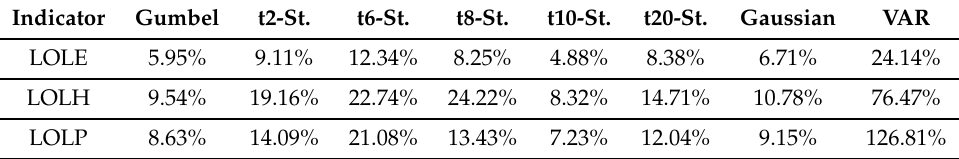
Table 4. MAPE values for different models. VAR: vector autoregressive